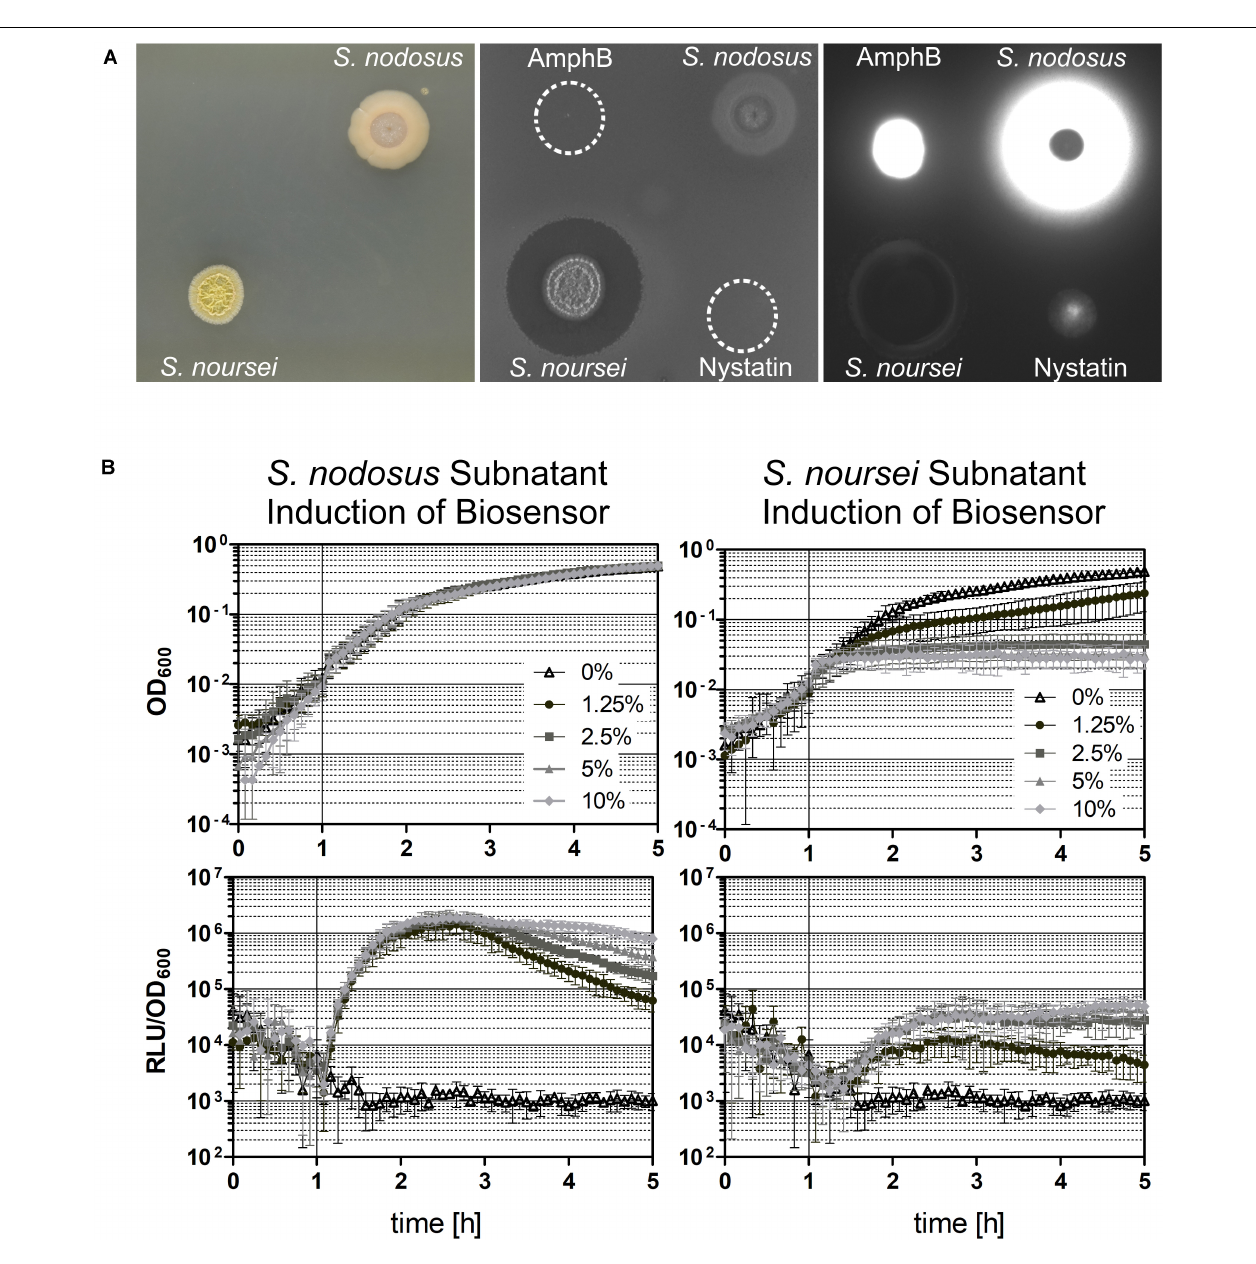
FIGURE 6 | Induction of the (cid:49) lnrLMN P lnrL 231 - lux (TMB5600) biosensor with Streptomyces spp. subnatants. The biosensor was tested for its robustness by analyzing its ability to detect polyenes in a complex mixture of different produced compounds by the two Streptomyces species S. nodosus and S. noursei, which are known producers of amphotericin B and nystatin, respectively. (A) Spot-on-lawn in solid medium. Both Streptomyces spp. strains were grown on solid medium for 4 days at 28 ◦ C (left picture), before they were overlaid with the biosensor strain (middle picture) and the produced luminescence signal was detected (right picture). In addition, 20 µ l of amphotericin B (AmphB) and nystatin stock solutions were spotted on top of the overlay as controls. (B) Induction in liquid medium. The (cid:49) lnrLMN